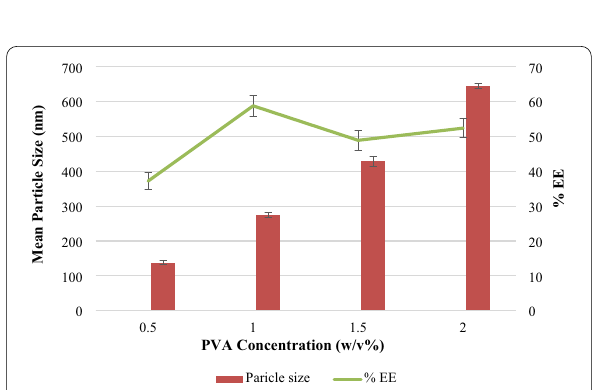
Fig. 2 Influence of PVA (stabilizer) concentration on the particle size and %